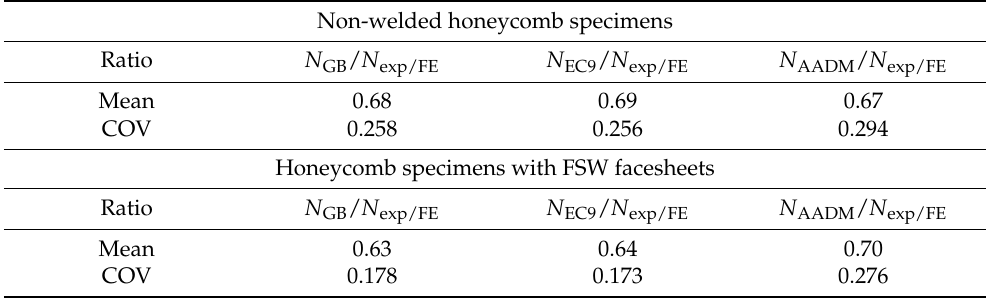
Figure 14. Comparisons of test and FE results with GB 50429, EC9 and AADM for honeycomb specimens with FSW facesheets: ( a ) GB 50429; ( b ) EC9; ( c ) AADM. Table 6. Comparison of test/FE results with codified predicted